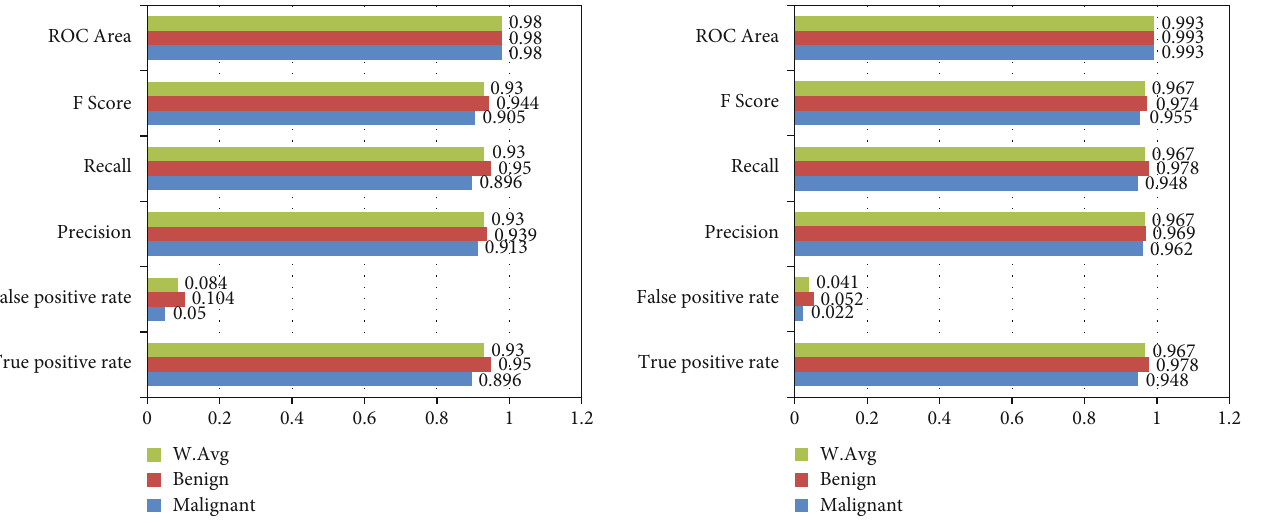
Figure 6: Accuracy and sensitivity information of the multilayer perceptron technique. Table 4: Complexity matrix of the SVM technique.